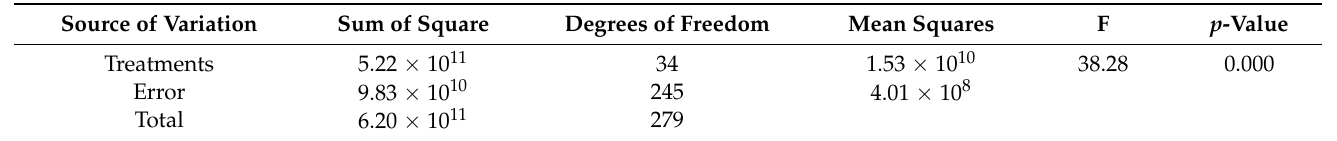
Table 10. ANOVA analysis for the total energy.